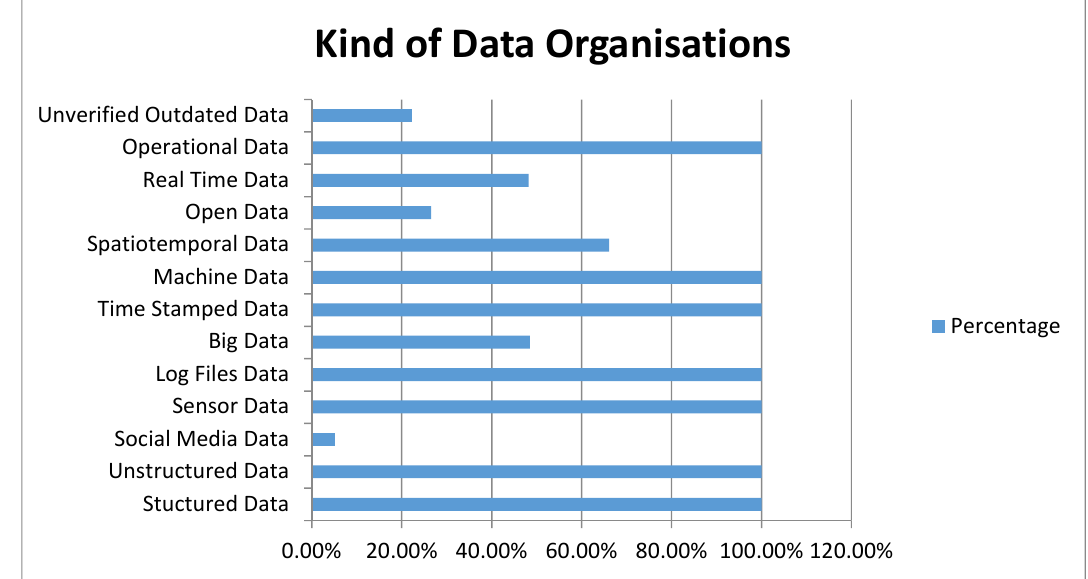
Figure 3. Kinds of data held by organisations.